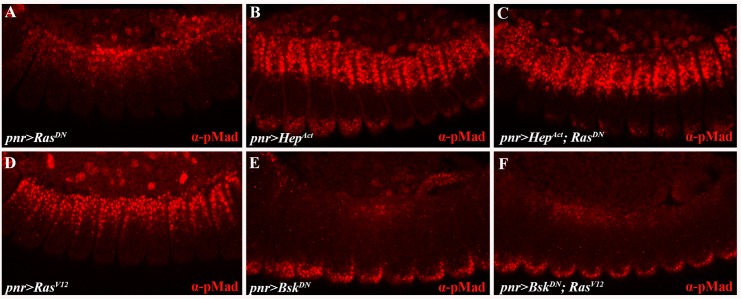
Egfr signaling acts upstream of the JNK cascade in dorsal closure.(A-F) Embryos stained for pMad (red). pMad staining decreases in embryos expressing pnr>RasDN (A) and expands in embryo expressing pnr>HepAct (B). In embryos co-expressing pnr>HepAct; RasDN, pMad staining expands (C). pMad staining expands in embryo expressing pnr>RasV12 (D) and is largely reduced in embryo expressing pnr>BskDN (E). In embryos co-expressing pnr>BskDN; RasV12, pMad staining is also reduced (F). These results indicate that JNK signaling is epistatic to the Egfr pathway.